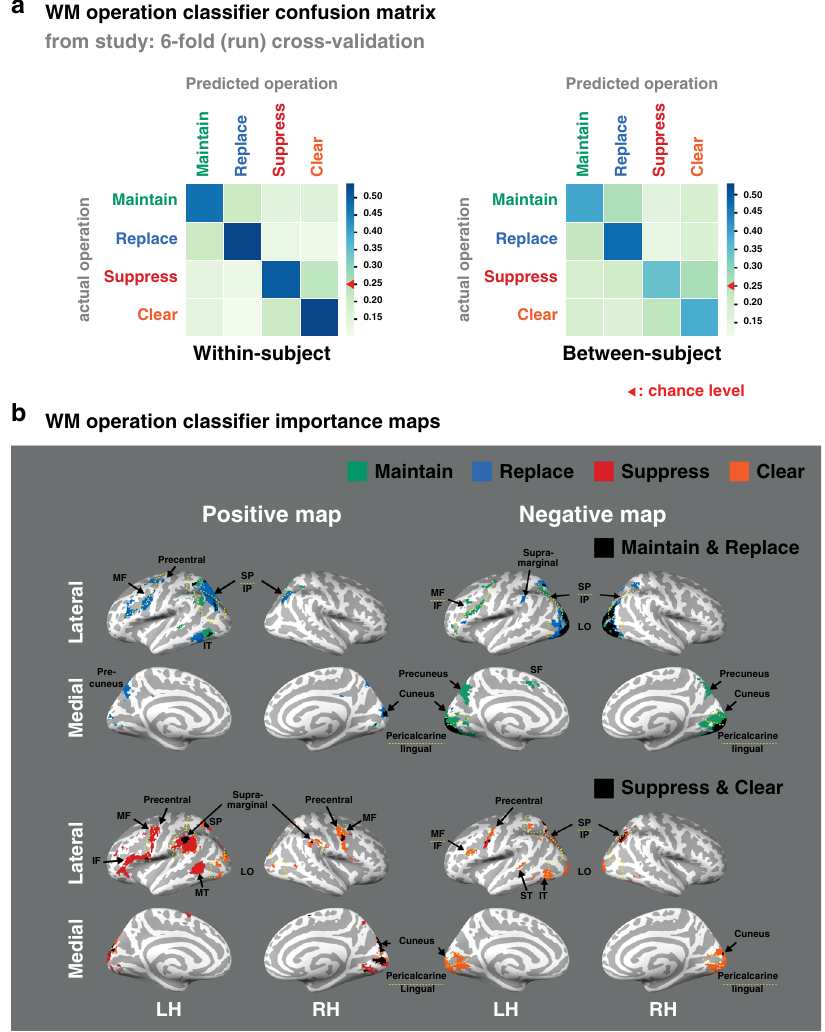
Fig. 2 WM operation multivariate pattern analysis. a Classi fi er confusion matrix for decoding the operation being engaged on each trial of the central study with within-subject classi fi ers [ N = 50 participants; left] and between-subject classi fi ers [ N = 49 participants; right]. Source data are provided as a Source Data fi le. b The classi fi er importance maps highlight voxels that were identi fi ed as important for identifying each operation (positive: increased activity is important; negative: decreased activity is important). The cortical labels were adapted from Mindboggle-101 provided in FreeSurfer 58 . S/M/I superior/middle/inferior, F/P/T frontal/parietal/temporal, LO lateral occipital, LH/RH left/right hemisphere. The different operations are colored according to the legend in a , with black representing overlap between maintain & replace (top) and suppress & clear (bottom). See Supplementary Table 1 for the